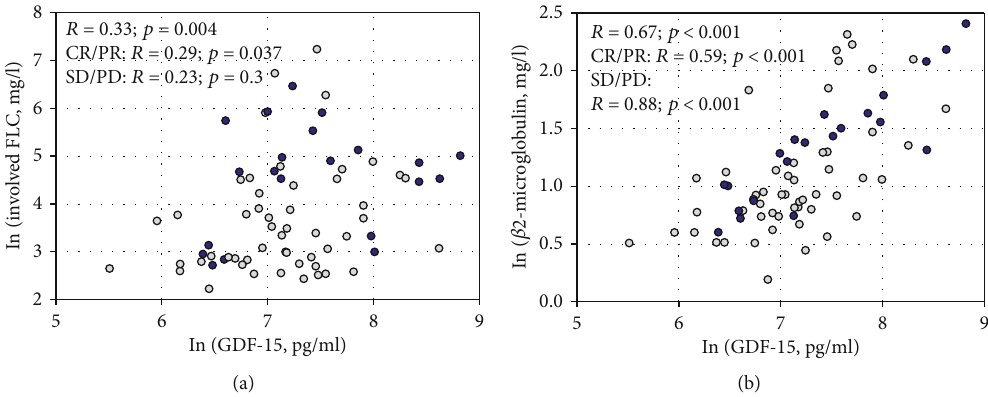
Figure 2: Correlations between serum GDF-15 concentrations and involved serum free light chains (FLC) (a) and β 2-microglobulin (b) in studied patients. Light circles represent patients with complete or partial remission (CR/PR), and dark circles represent patients without remission (stable disease or progressive disease, SD/PD). The right-skewed variables were transformed using the natural logarithm (ln) to enhance readability. The Spearman rank-order correlation coe ffi cients ( R ) in the whole studied group and the subgroups are shown with associated p